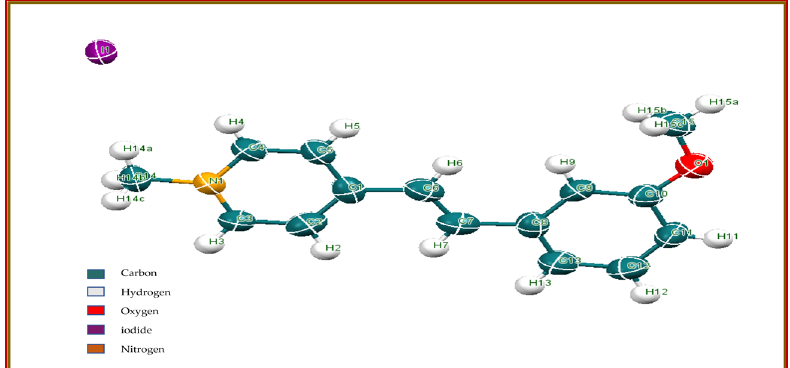
Figure 3. ORTEP Diagram for MMPI. Table 2. Selected the Bond lengths (Å) and Bond angles ( ◦ ) for MMPI